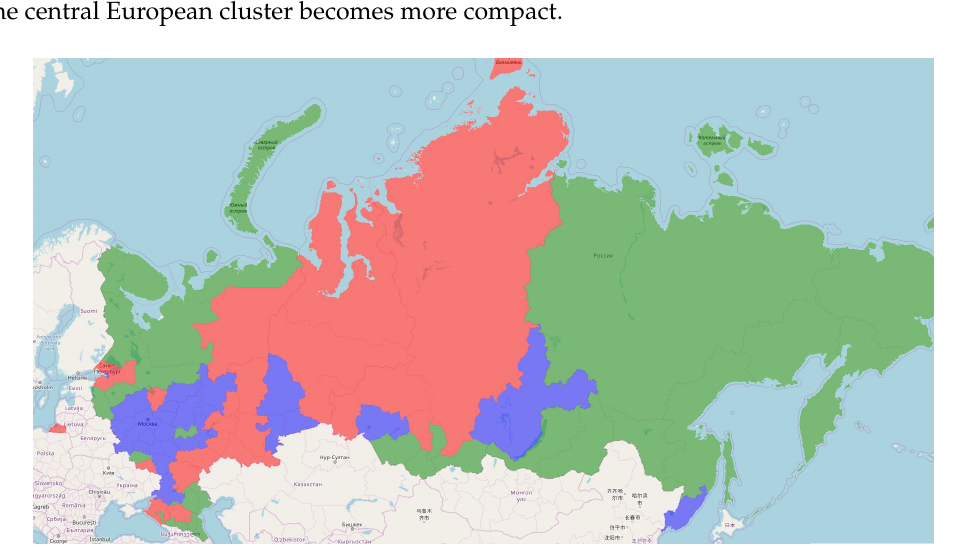
Figure 1. Regions of Russia, clustering by specialization, 2010.